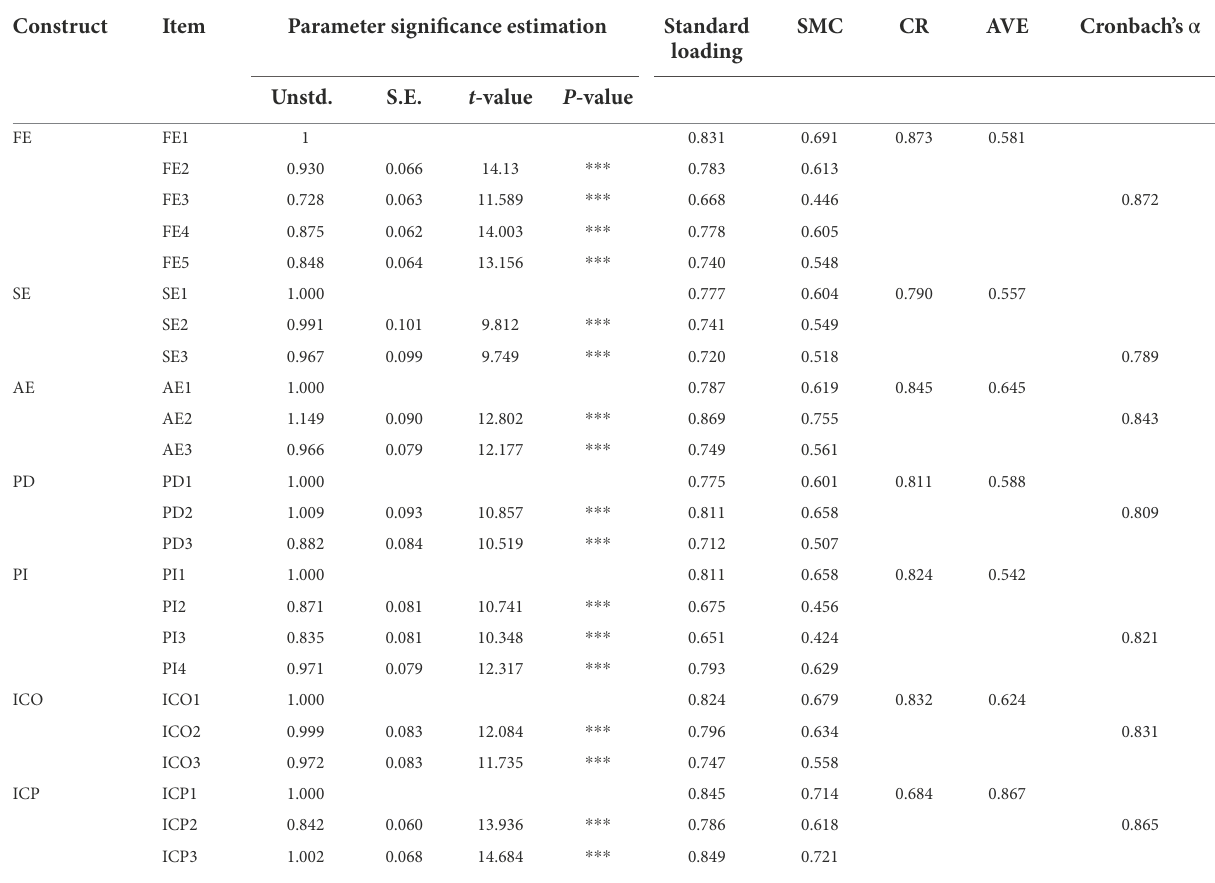
TABLE 2 Confirmatory factor analysis results.